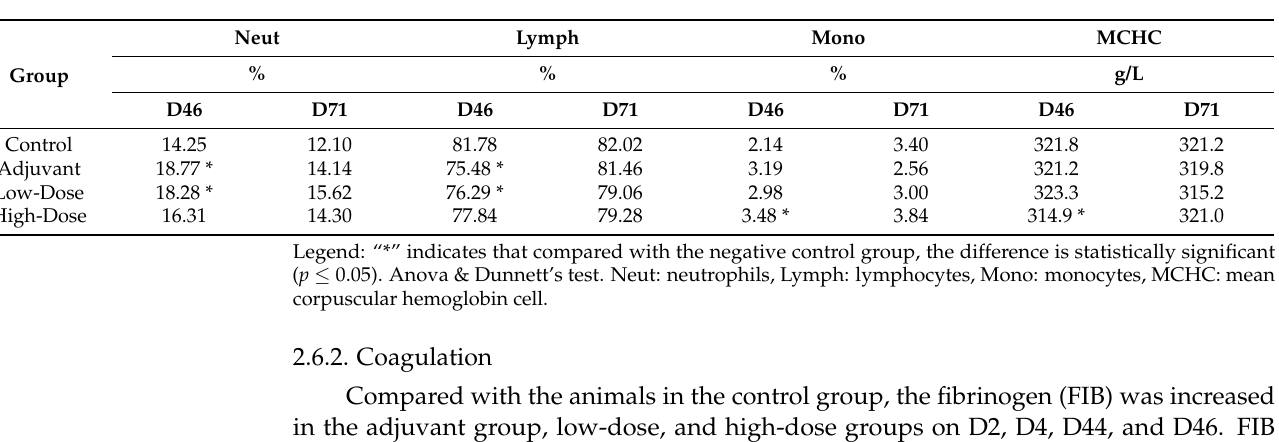
Table 2. Changes in some blood cells in each group 3 days after the last administration (D46 and D71).